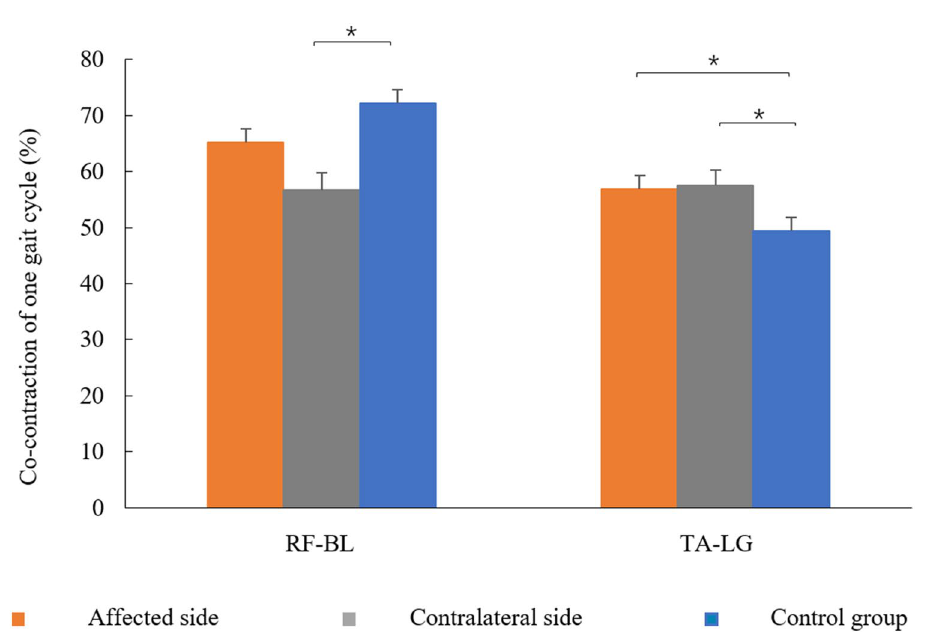
Figure 5. The co-contraction between rectus femoris (RF) and biceps femoris long head (BL), as well as tibialis anterior (TA) and lateral gastrocnemius (LG) of one gait cycle in the control and the affected and contralateral